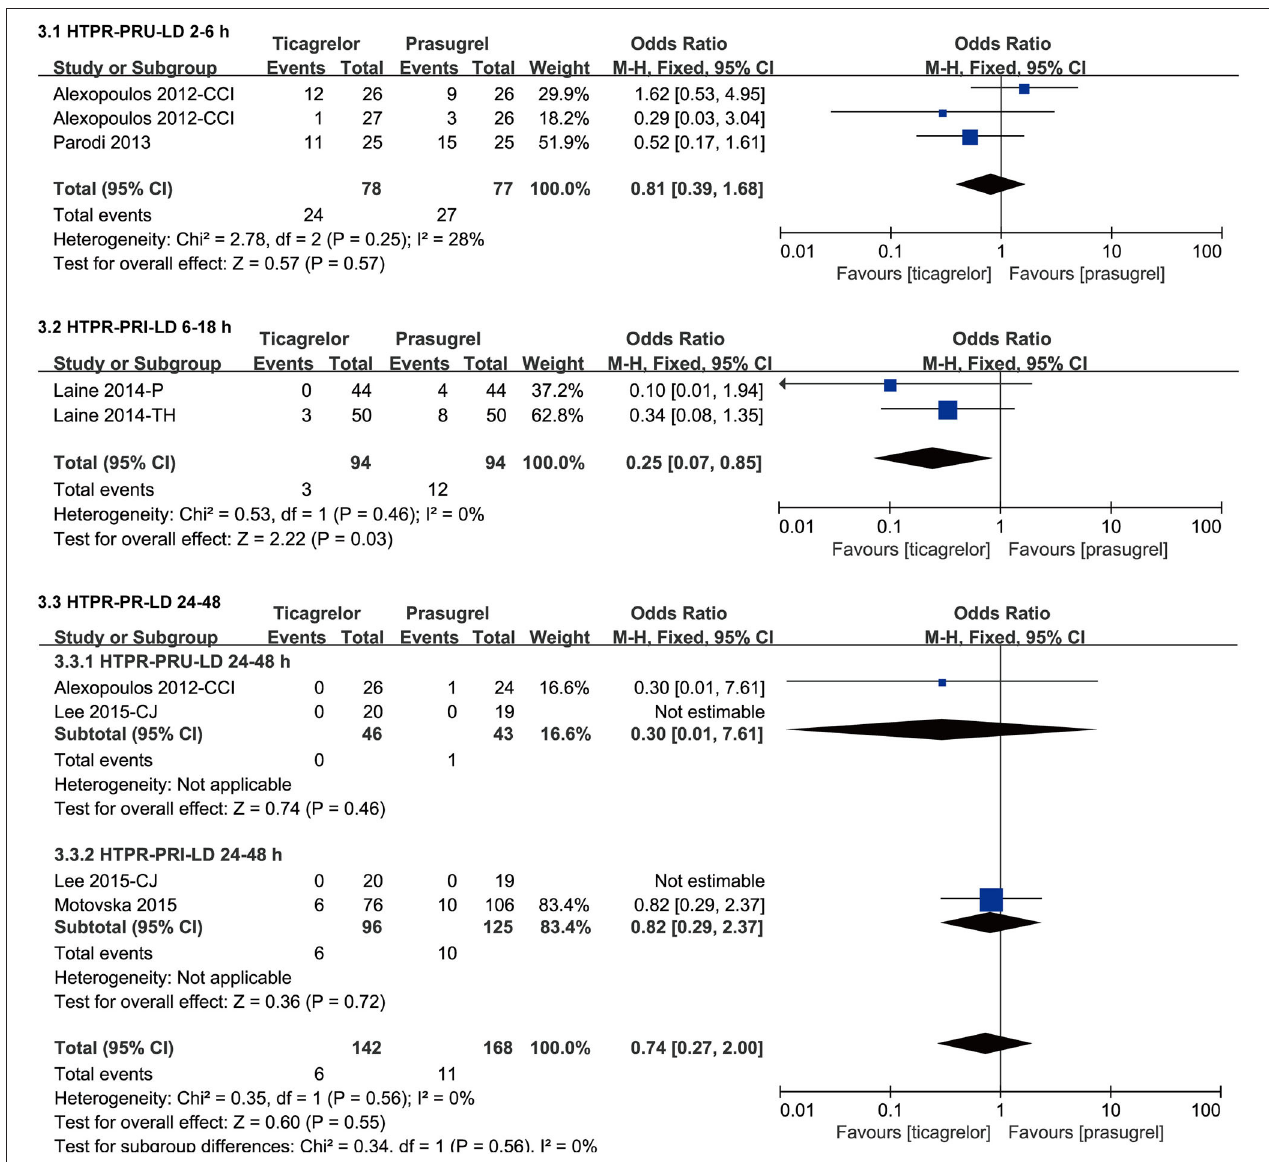
FIGURE 6 | Forest plots of meta-analysis results of HTPR after